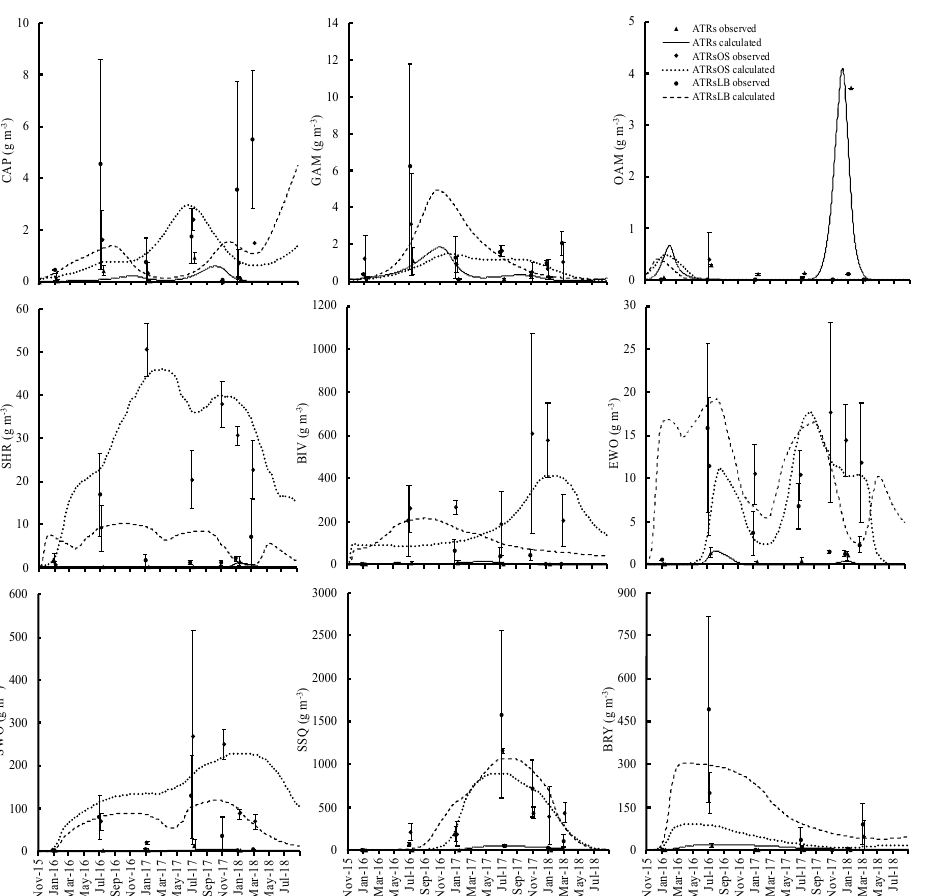
Figure 3. Relative temporal changes in attached organisms on simple artificial timber reefs and those with either supplementary oyster shells or supplementary leaf and branch materials.